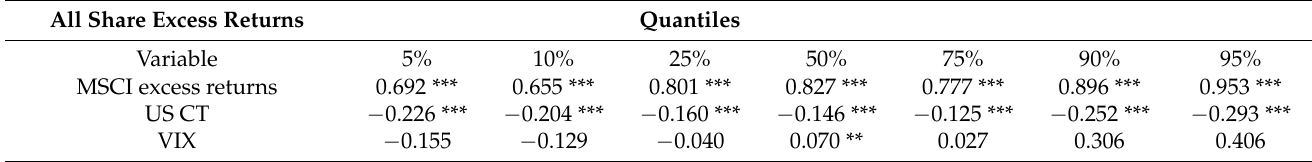
Table 6. Equities market results analysis (US carry trade).